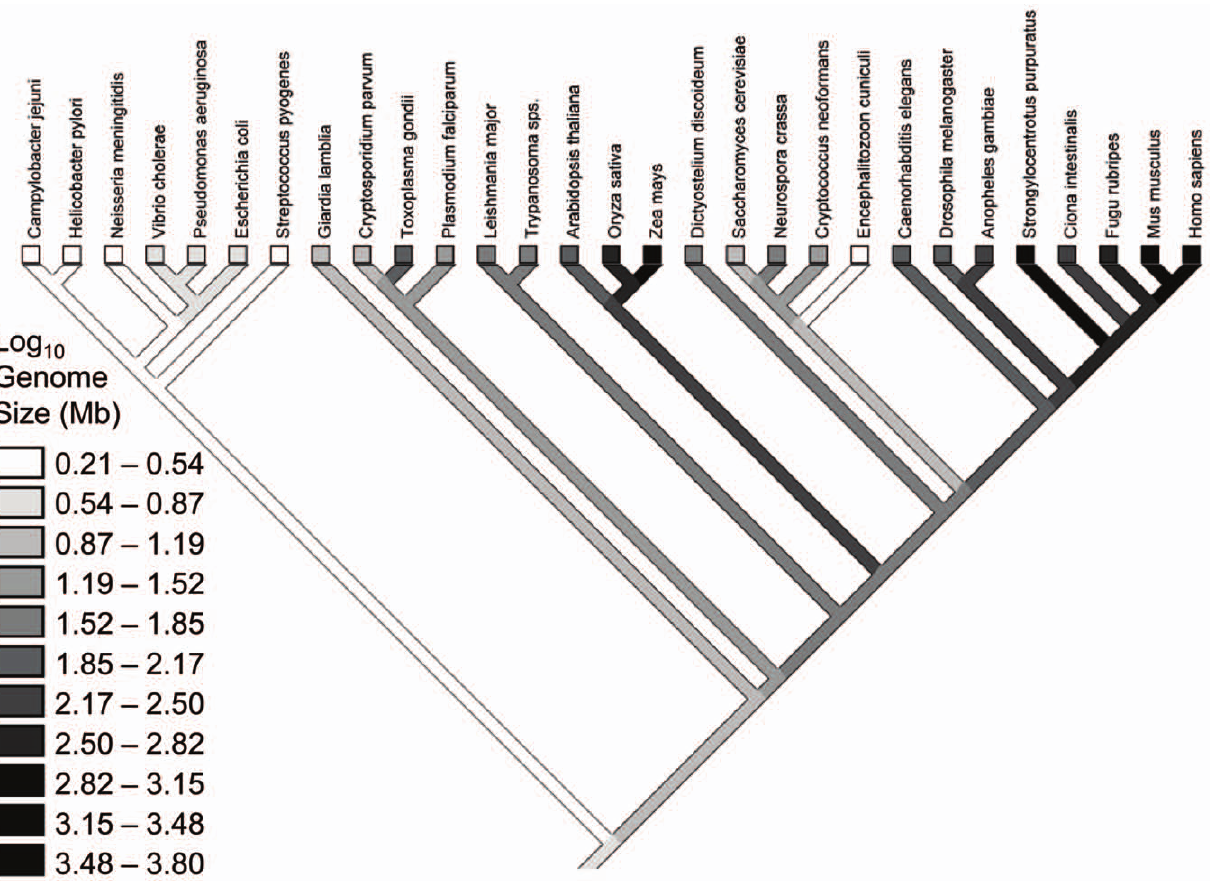
Figure 2. Phylogeny for the species in the Lynch & Conery dataset [ 7 ] , with a reconstruction of genome sizes. (See Materials and